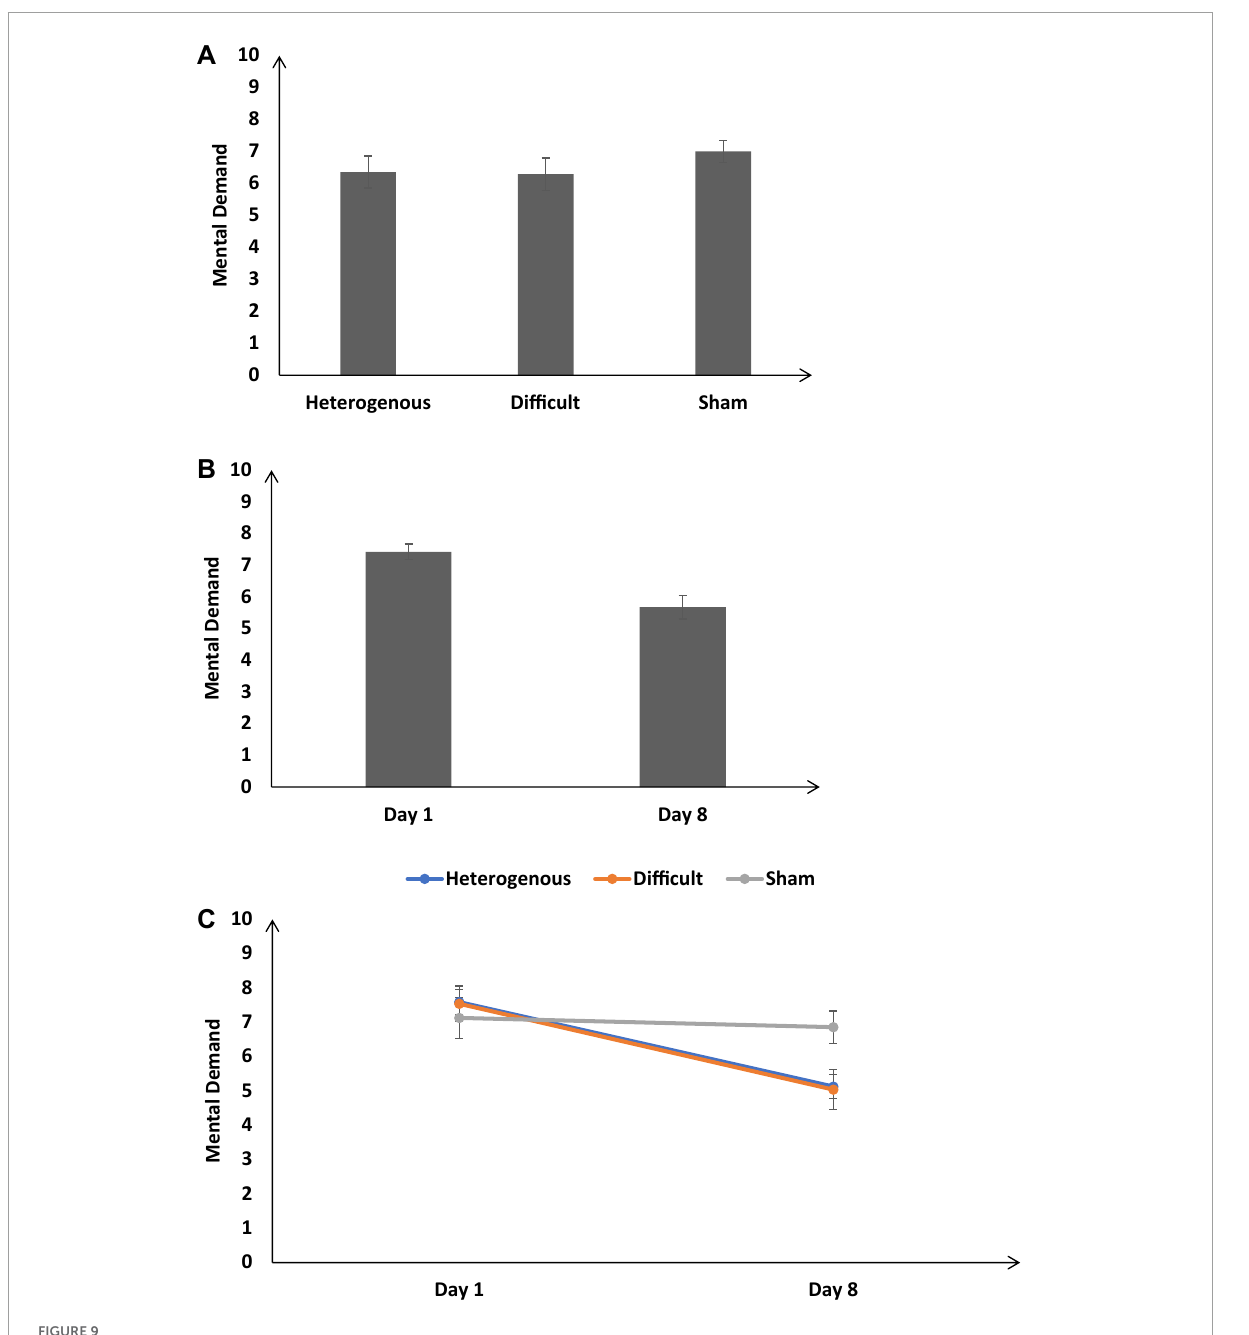
FIGURE9 (A) The self-reported mental demand across different training conditions. (B) The mental demand across different baseline days (Day 1 and Day 8). (C) The mental demand across different training conditions and baseline days (Day 1 and Day 8). The error bars show 95% CI around point